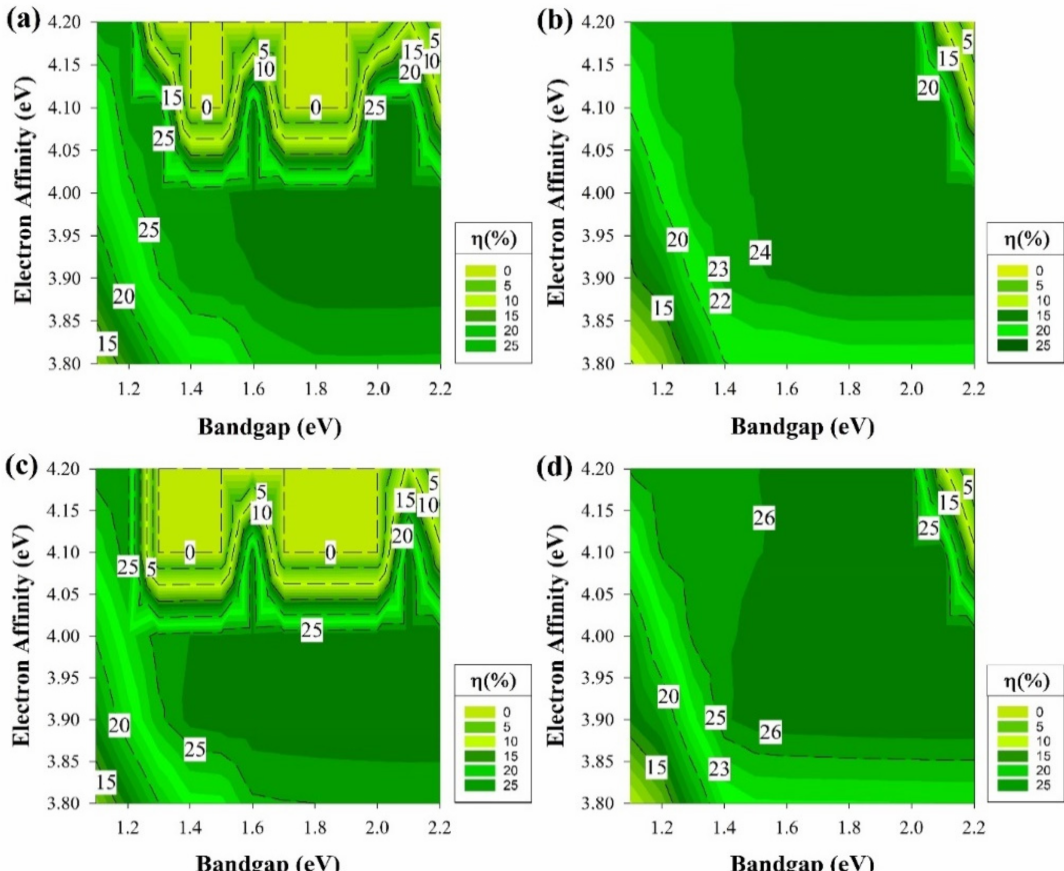
Figure 10. The efficiency of four proposed structures, including a-Si:H passivating layers as a function of Eg and χ for doped layers with defects at the middle of E g ( a ) Contour graphs of the n-i-p structure with p-type wafer base. ( b ) Contour graphs of the n-i-p structure with n-type wafer base. ( c ) Contour graphs of the p-i-n structure with the p-type wafer. ( d ) Contour graphs of the p-i-n structure with n-type wafer